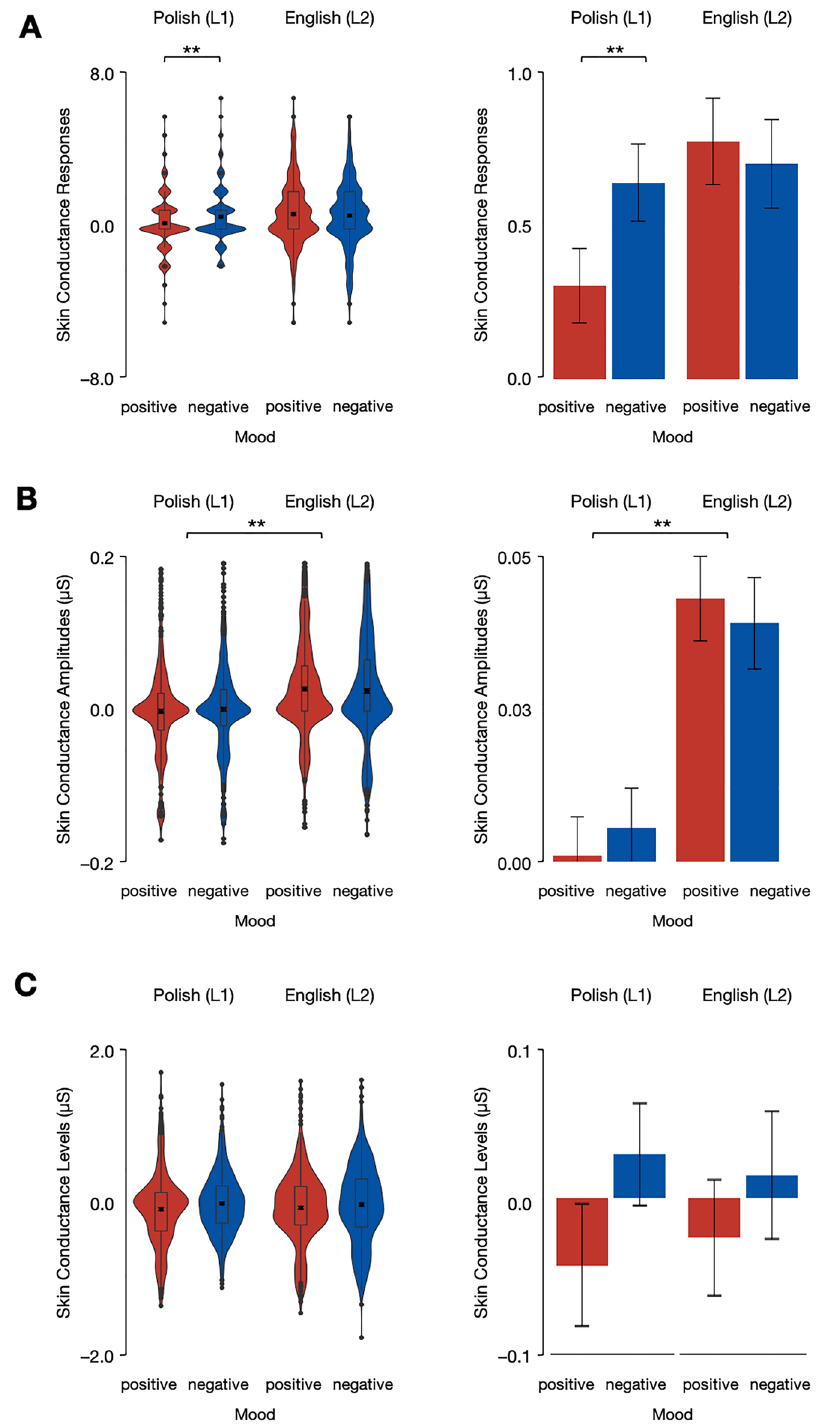
Figure 2. Skin conductance responses ( A ), amplitudes ( B ), and levels ( C ) in English (L2) and Polish (L1) in the negative (blue) and positive (red) mood conditions. Error bars represent 95% confidence